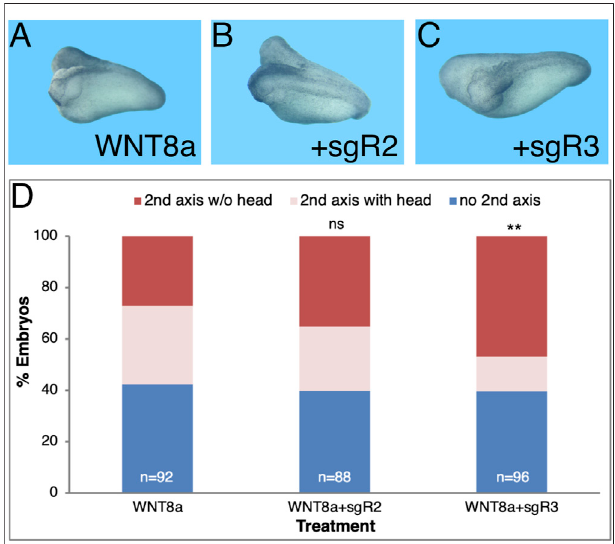
FIGURE 6 | aldh1a3 CRISPants exhibit enhanced head malformations. Secondary axes were induced by ventrally injecting wnt8a mRNA. Co- injection of sgR2 or sgR3 RNPs was performed to generate aldh1a2 or aldh1a3 CRISPant embryos, respectively. (A) Secondary axis induction ef fi ciencyin wnt8a RNAinjectedembryosalongorinconjunctionwith aldh1a2 or aldh1a3 CRISPant induction. (B) Control embryo. (C) aldh1a2 CRISPant embryo with two axes. (D) aldh1a3 CRISPant twinned axis embryo. (E) Analysis of the effect of the aldh1a2 and aldh1a3 CRISPR/Cas9-mediated knockdown on head formation in the induced secondary axes. The overall number of embryos injected or manipulated is shown ( n =). Percent embryos wnt8a mRNA injected, embryos with secondary axes without heads and with heads. **, p < 0.01; ns, not signi fi